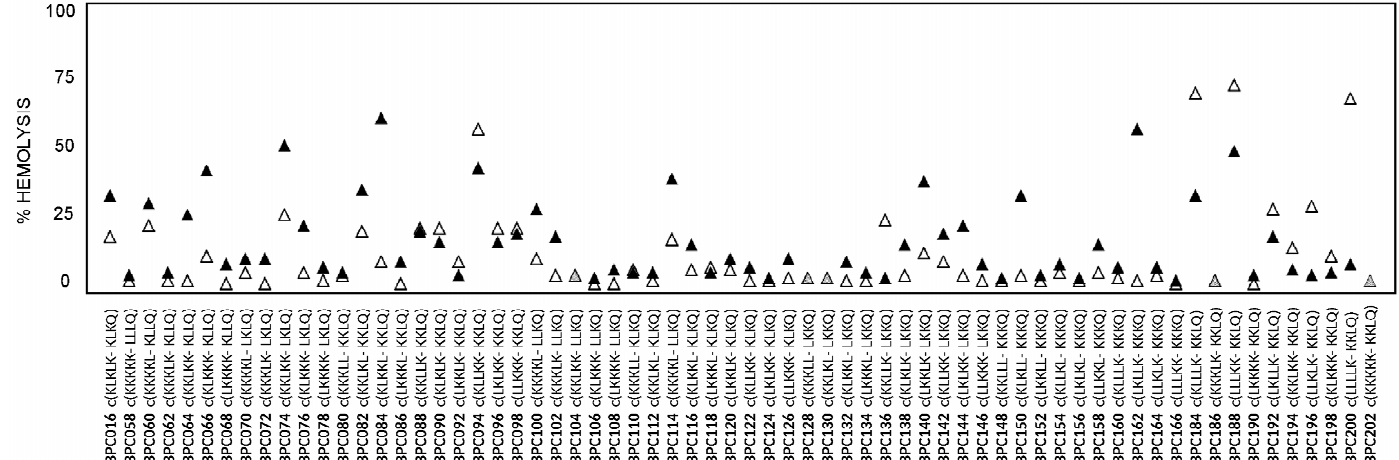
Figure 2. Hemolytic activity of the cyclic peptides incorporating a Trp or a Phe. Sequences and codes of the cyclic peptides are depicted, “-” stands for Trp (W) or Phe (F). Hemolytic activity was measured at 125 µ M and is expressed as a percentage compared to melittin as a standard. Black triangles correspond to peptides with a Trp, white triangles to peptides with a Phe and grey triangles to peptides that display the same hemolysis. Data can be found in Table S1 (Supporting Information).